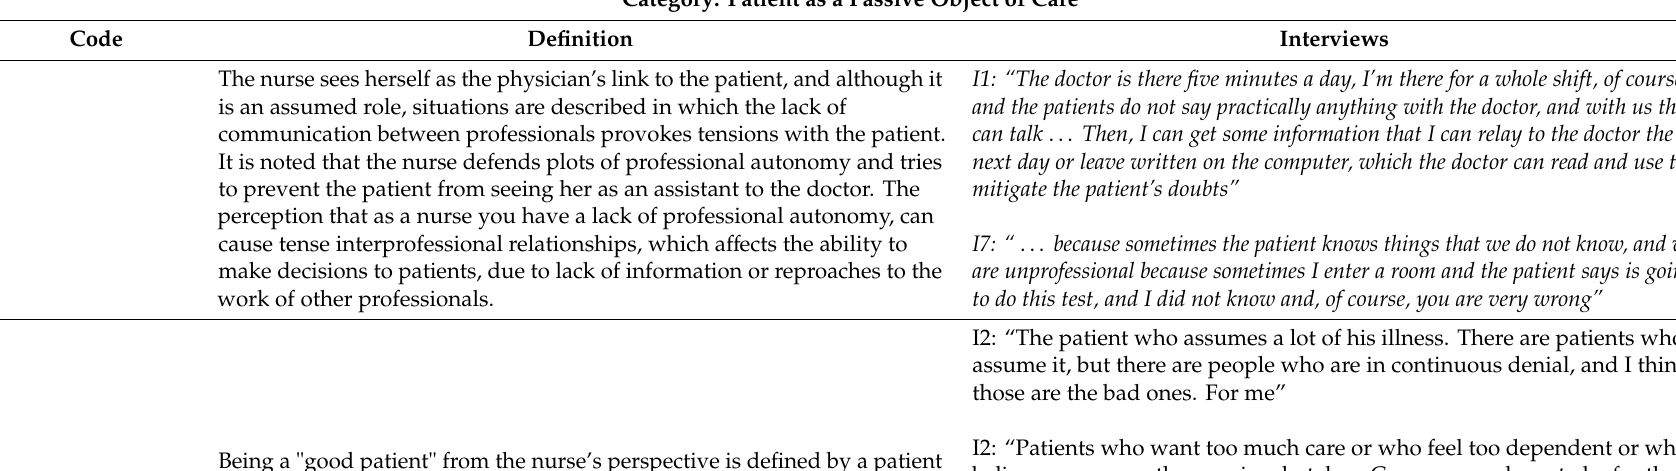
Category: Patient as a Passive Object of